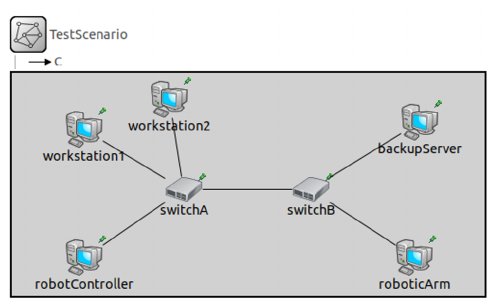
Figure 10. TSN topology of the simulation experiment that was built based on NeSTiNg.